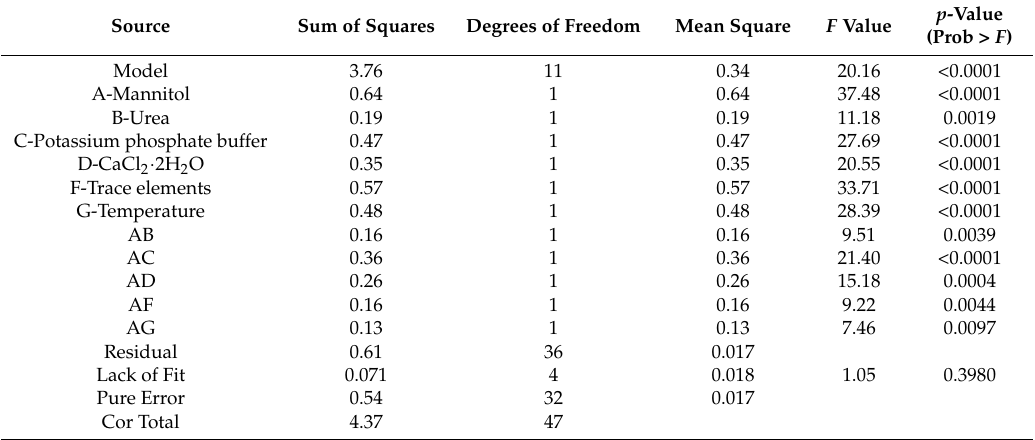
Table 4. ANOVA analysis for the reduced regression model of rhamnolipid production. Source